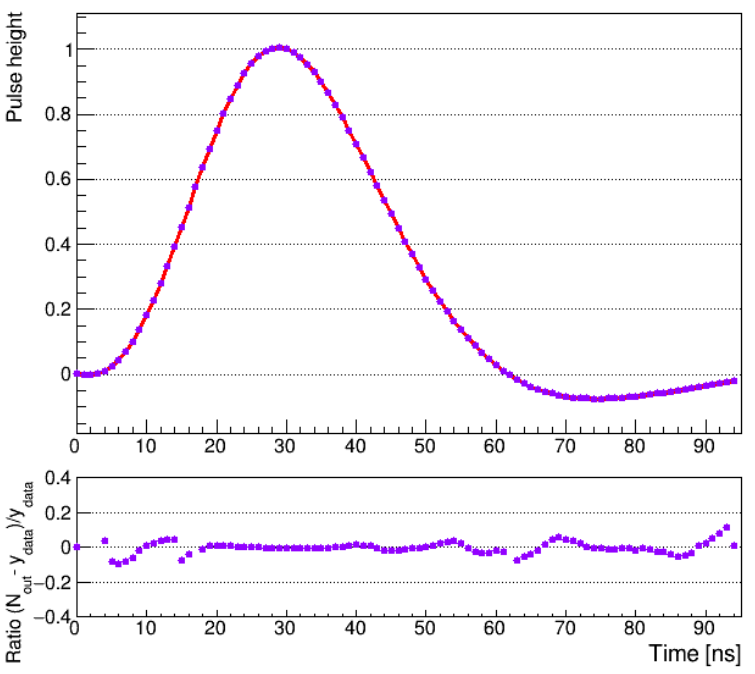
Figure 4. The pulse shape recreated by the neural network along with the ratio of the residuals N out − y data to the mean pulse shape y data representing the uncertainty of the estimated pulse